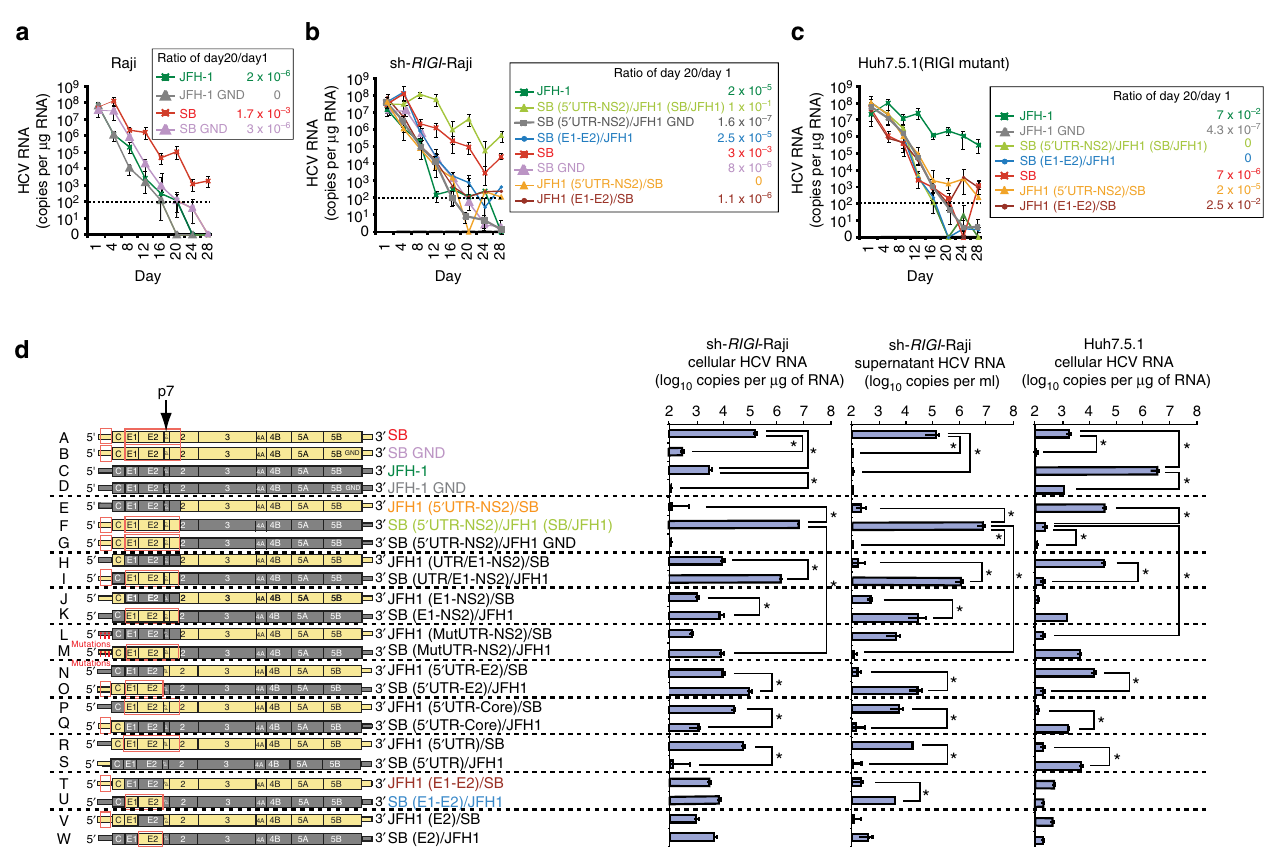
Figure 1 | Genetic determinants of tissue tropism of HCV SB and JFH1 viruses. ( a – c ) HCV virus RNA in the parental Raji cells ( a ), RIG-I knockdown Raji (sh- RIGI -Raji) cells ( b ) or Huh7.5.1 cells ( c ). Cells were harvested from day 1 until day 28 after HCV RNA transfection. The HCV RNA titers were determined by qRT-PCR (performed in quadruplicates, n ¼ 3). Error bars represent s.d. ( d ) Genetic structure of virus chimera assembled from the SB and JFH-1 strains. The chimeric viruses were transfected into Raji (sh- RIGI -Raji) or Huh7.5.1 cells as indicated; cellular HCV RNA was quantitated by qRT-PCR at 24 days after transfection (Left and Right). The HCV RNA titers in the supernatant are shown in ( d , middle). HCV SB, but not commonly studied JFH-1 strain, preferentially infects, replicates and produces virion particles in sh- RIGI -Raji lymphoma B cells, but not in Huh7.5 hepatocyte cells ( n ¼ 3). Error bars represent